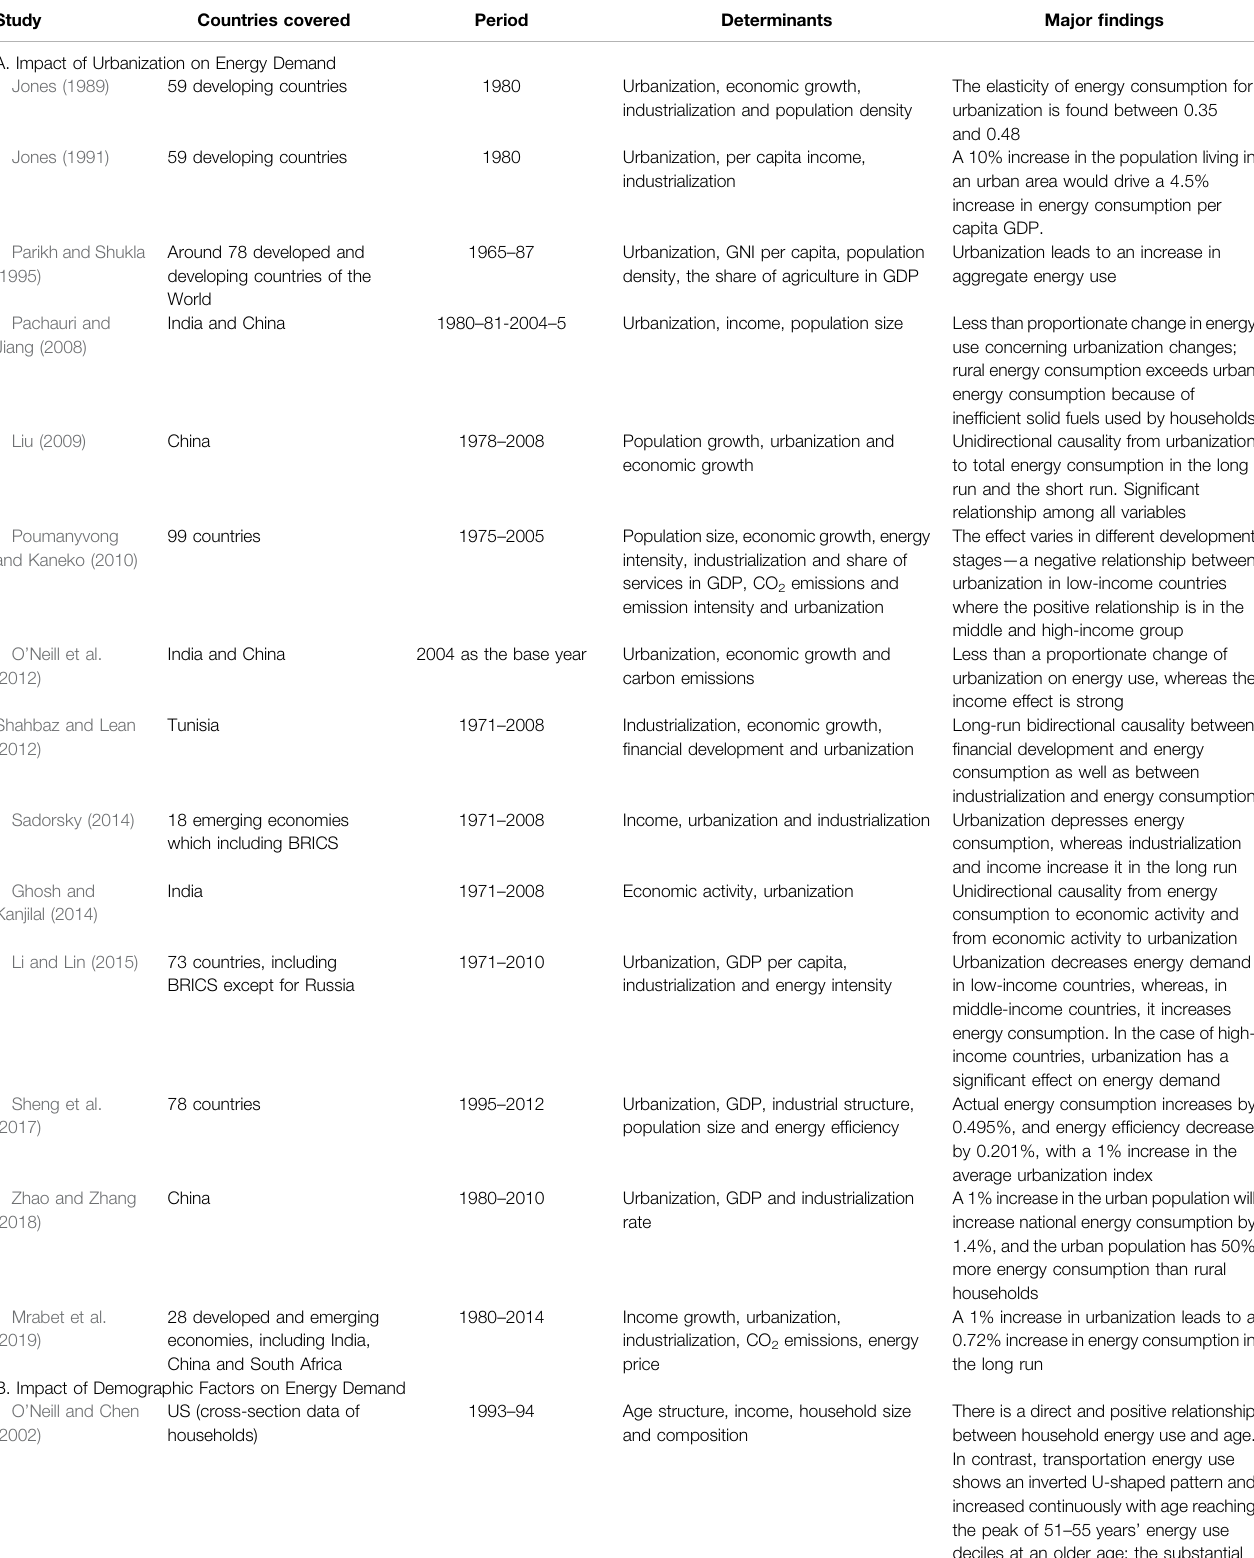
TABLE 1 | Summary of representative